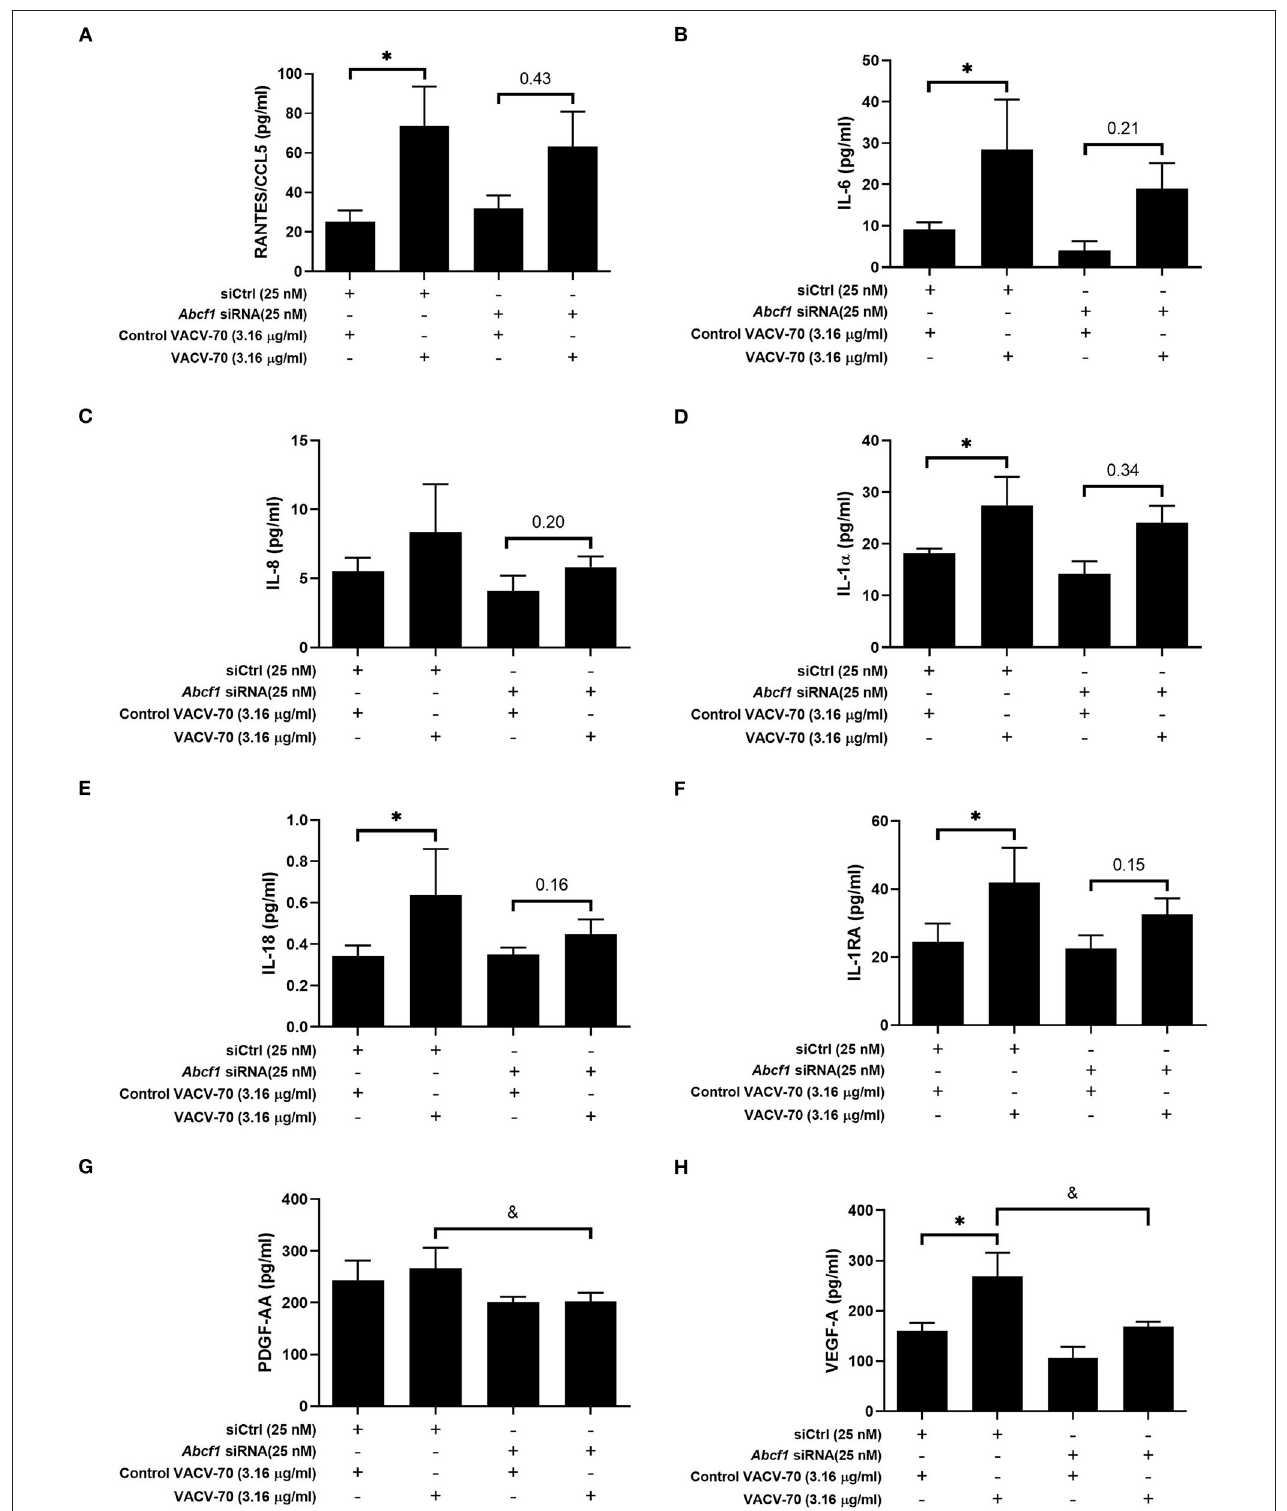
FIGURE 5 | Impact of ABCF1 reduction on VACV-70 stimulated cytokine production–Inflammatory cytokines and growth factors. VACV-70 (3.16 µ g/ml)-induced cytokine protein production for HBEC-6KT cells with ABCF1 siRNA treatment. (A) RANTES/CCL5, (B) IL-6, (C) IL-8, (D) IL-1a, (E) IL-18, (F) IL-1RA, (G) PDGF-AA, (H) VEGF-A. All studies n = 3; * p < 0.05 relative to siCtrl + ctrl VACV-70; & = p < 0.05 relative to siCtrl + VACV-70.